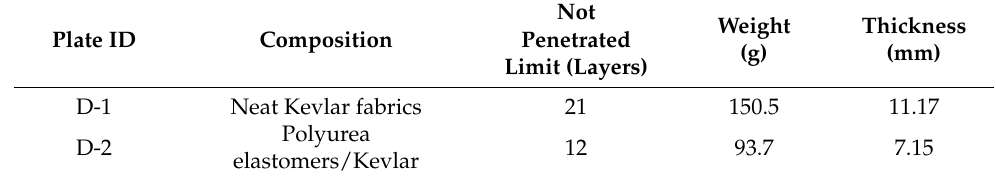
Table 3. Results for stab